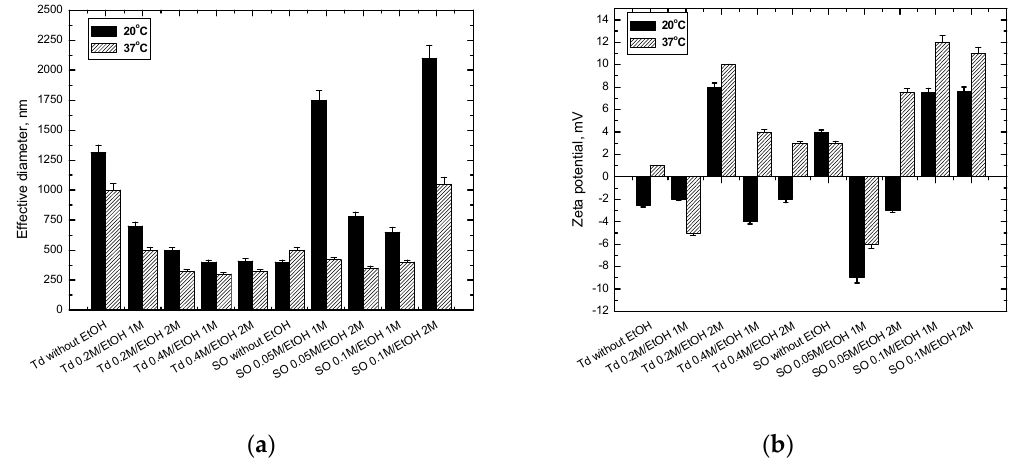
Figure 4. ( a ) The e ff ective diameter and ( b ) zeta potential of di ff erent CsA formulations at 20 and 37 ◦ C. Abbreviation: SO—soybean oil (0.05 M or 0.1 M), Td n -tetradecane (0.2 M or 0.4 M), EtOH ethanol solution (1 M or 2